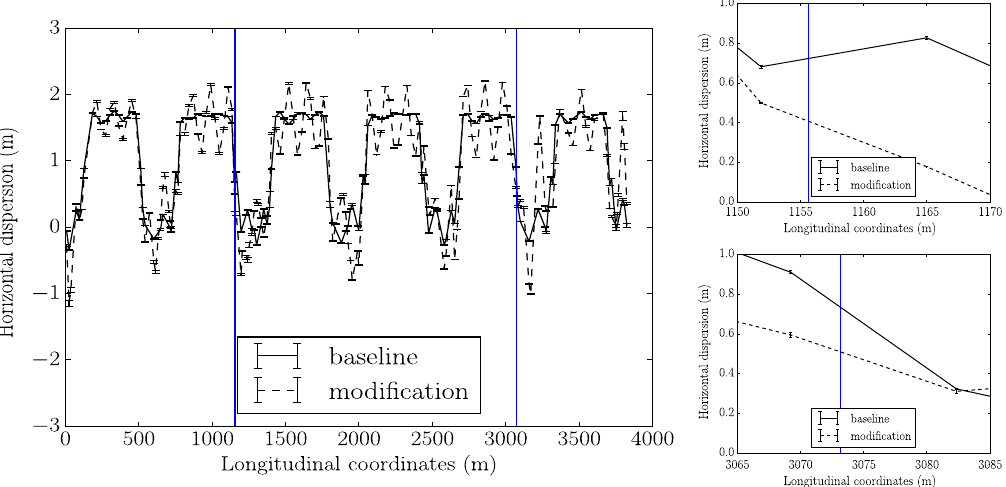
FIG. 6. Left plot: The measured horizontal dispersion functions at the beam position monitors at top energy before (the solid line) and after (the dashed line) the matching of the dispersion primes at the two Siberian snakes (located at the vertical lines) in the blue ring. Right plots: Expanded view of the dispersion functions at the first snake (the upper plot) and the second snake (the lower